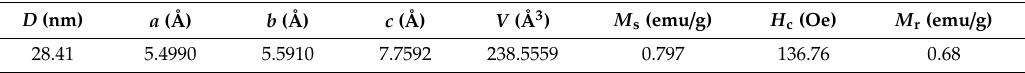
Table 1. Lattice parameters and magnetic properties of crystalline NdFeO 3 particles annealed at 750 ◦ C. D